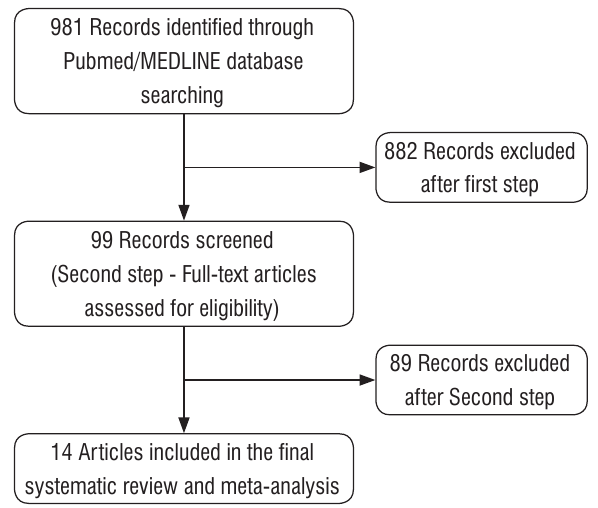
Figure 1 -Flow diagram of